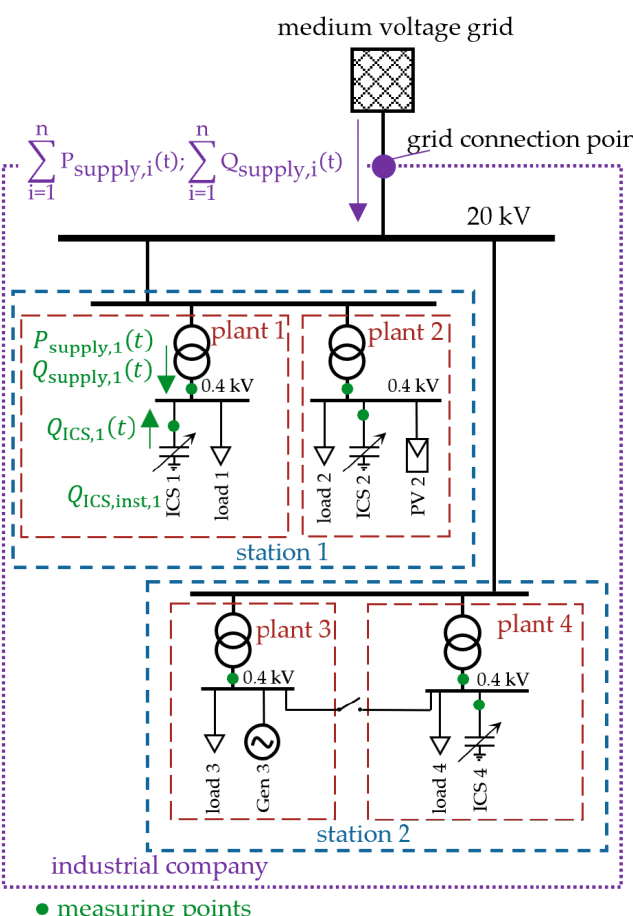
Figure 1. Composition and measuring points of an exemplary industrial-internal grid with two stations with two transformers each (four plants). stations with two transformers each (four plants). Table 1. Measurement input parameter for reactive power potential calculation.